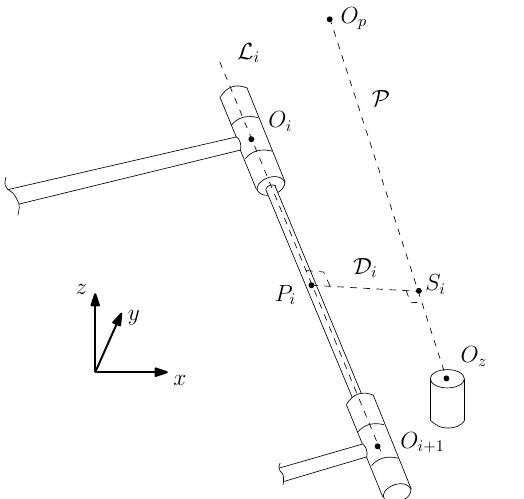
Figure 4. Schematic of the distance ( D i ) computed between the arm link and the line of sight to the